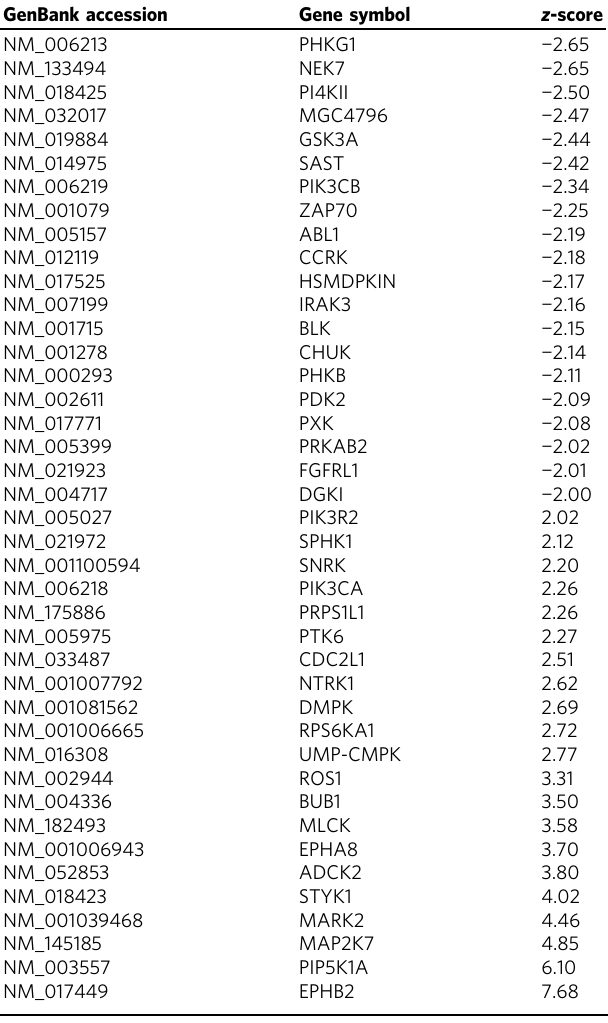
Table 3 siKinome screen hits in the MelJuSo- Mtb infection